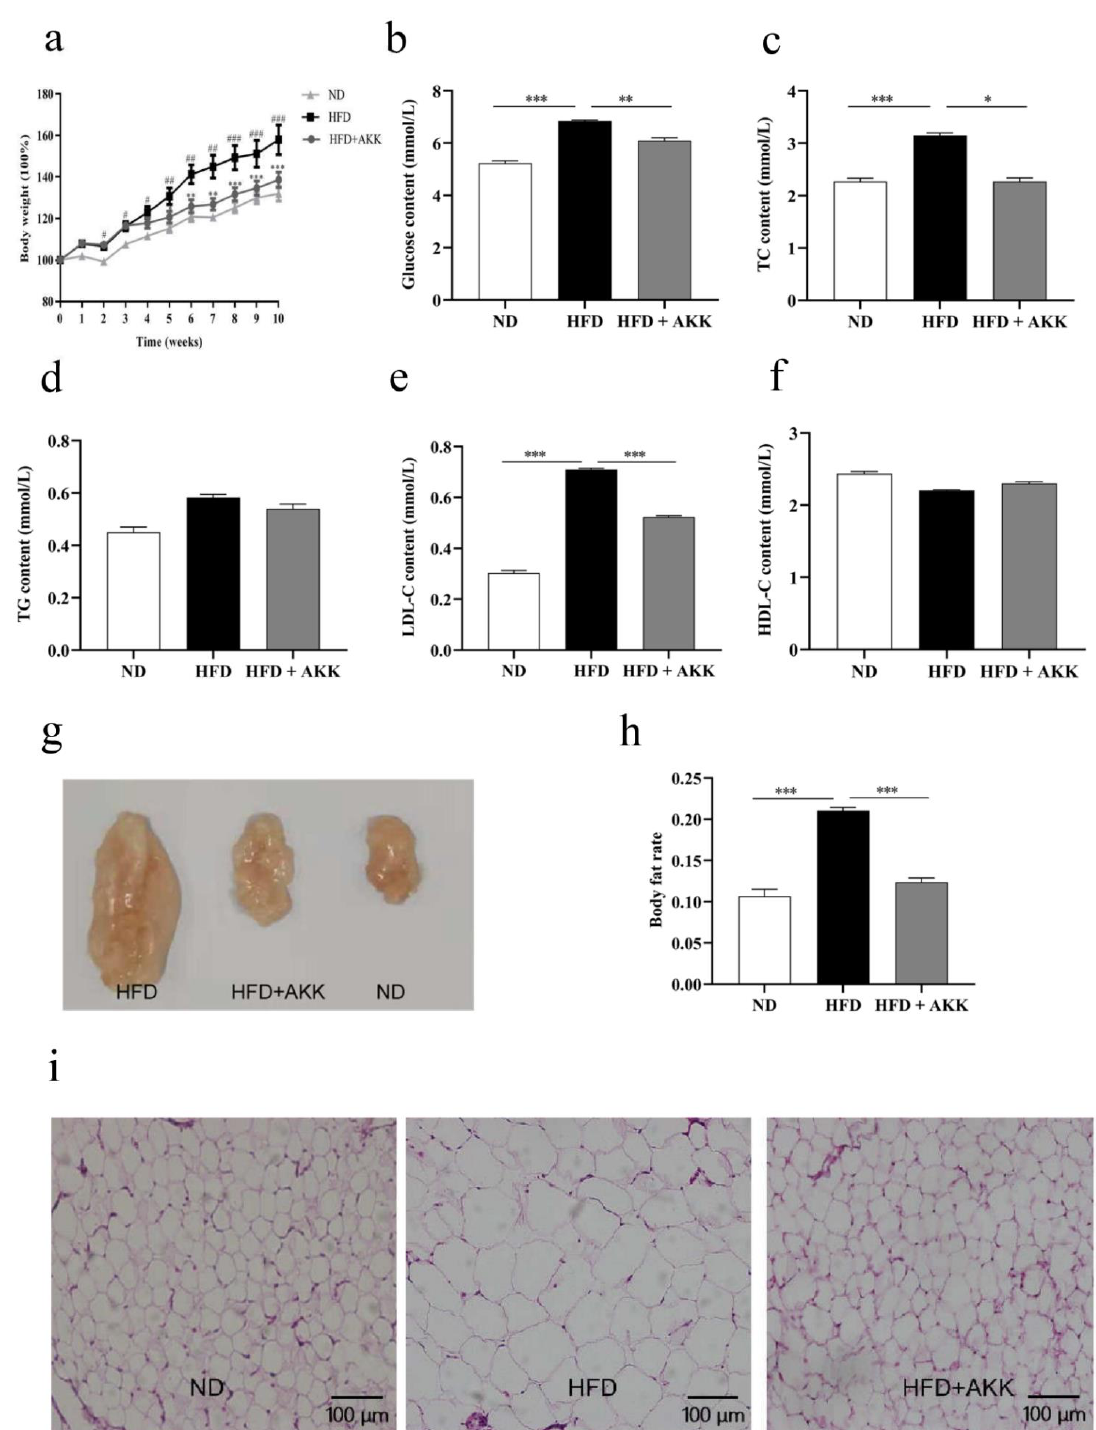
Figure 2. Effects of pasteurized A. muciniphila strain AKK2 on HFD-fed obese mice. ( a ) body weight measured weekly (data expressed as % of initial body weight). ( b ) serum level of fasting glucose, ( c ) total cholesterol (TC), ( d ) total triglyceride (TG), ( e ) LDL cholesterol (LDL-C) and ( f ) HDL choles- terol (HDL-C) in different experimental groups. ( g ) total abdominal fat, ( h ) body fat rate. ( i ) inguinal fat HE staining in different groups. The data are presented as the mean ± SEM ( n = 8). As for body fat rate, data expressed as the weight of total abdominal fat/body weight. Statistical analyses were performed with one-way ANOVA test. * p < 0.05, ** p < 0.01 and *** p <